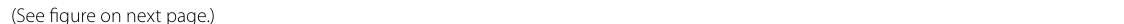
Fig. 3 The effect of HcaR on HCA degradation. a The domain organization of HcaR in Xcc . b Growth time course of XC1, Δ hcaR and Δ hcaR ( hcaR ) in NYG medium supplemented with 50 μM 4‑HCA. c – e Time course of HCA production by XC1, Δ hcaR and Δ hcaR ( hcaR ) in NYG liquid medium supplemented with 50 μM 4‑HCA, 50 μM 4‑FA or 50 μM CA. f Relative GUS activities of two reporter strains, XC1::P hca ‑ gusA and Δ hcaR ::P hca ‑ gusA when grown on NYG agar or liquid medium in the absence of HCAs. Averages with standard deviations of three independent experiments